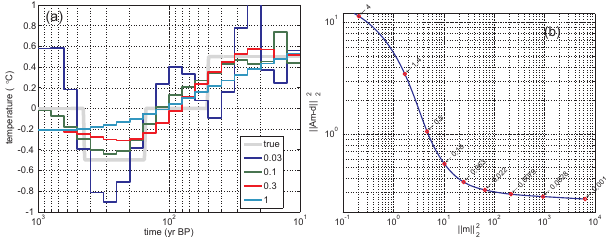
Fig. B2. Inversions of borehole temperature profiles for a fixed depth (500m), where a GSTH of constant value before the LIA is assumed. Results for different values of the regularization parame- ter are shown in (a) . The corresponding L-curve (Hansen, 2010) is shown in panel (b)